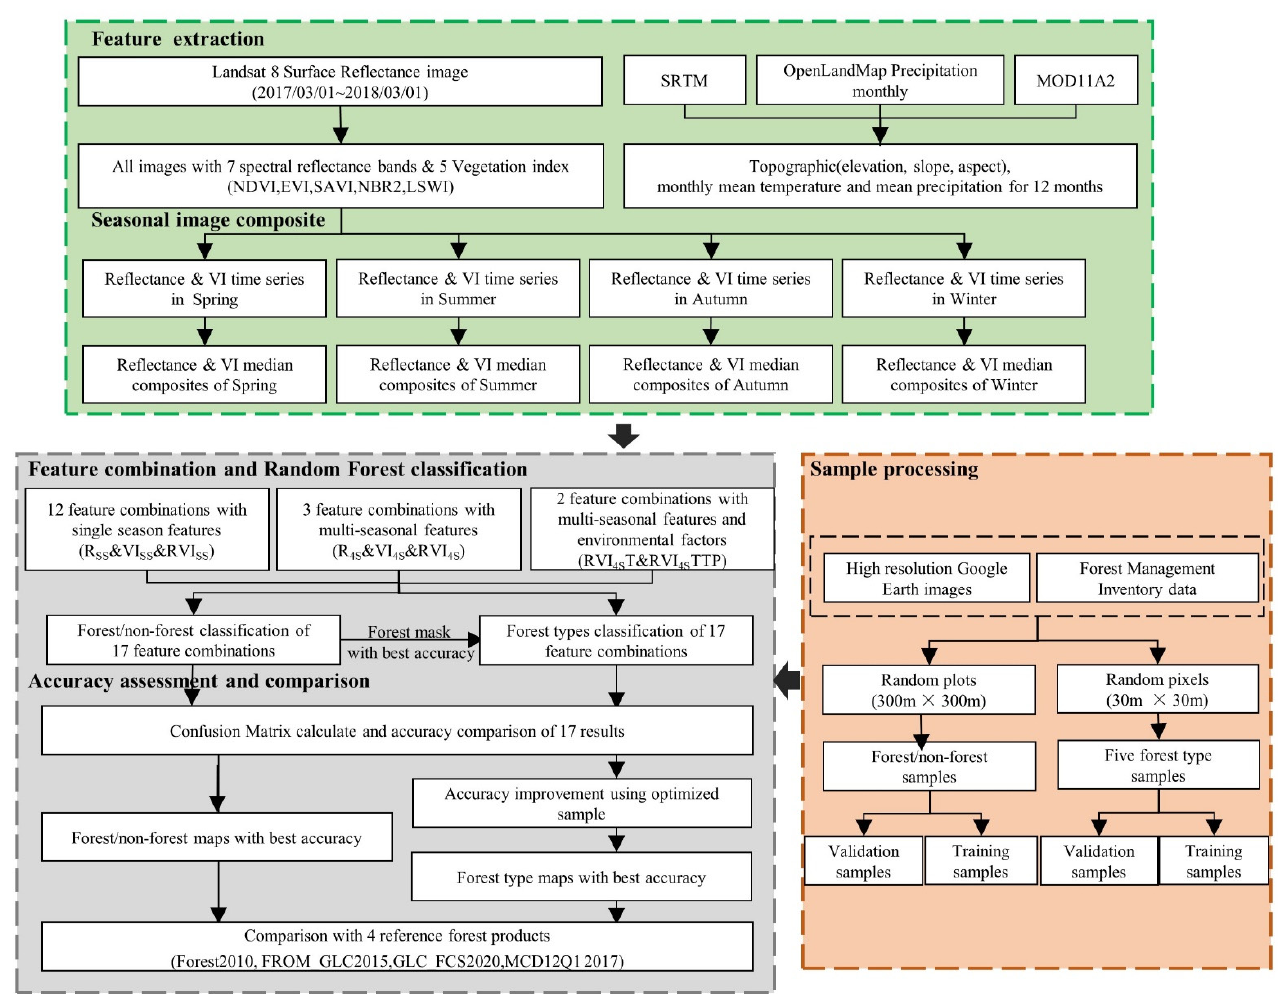
Figure 4. Methodological workflow of forest classification using a Random Forest classifier based on the Google Earth Engine cloud platform.